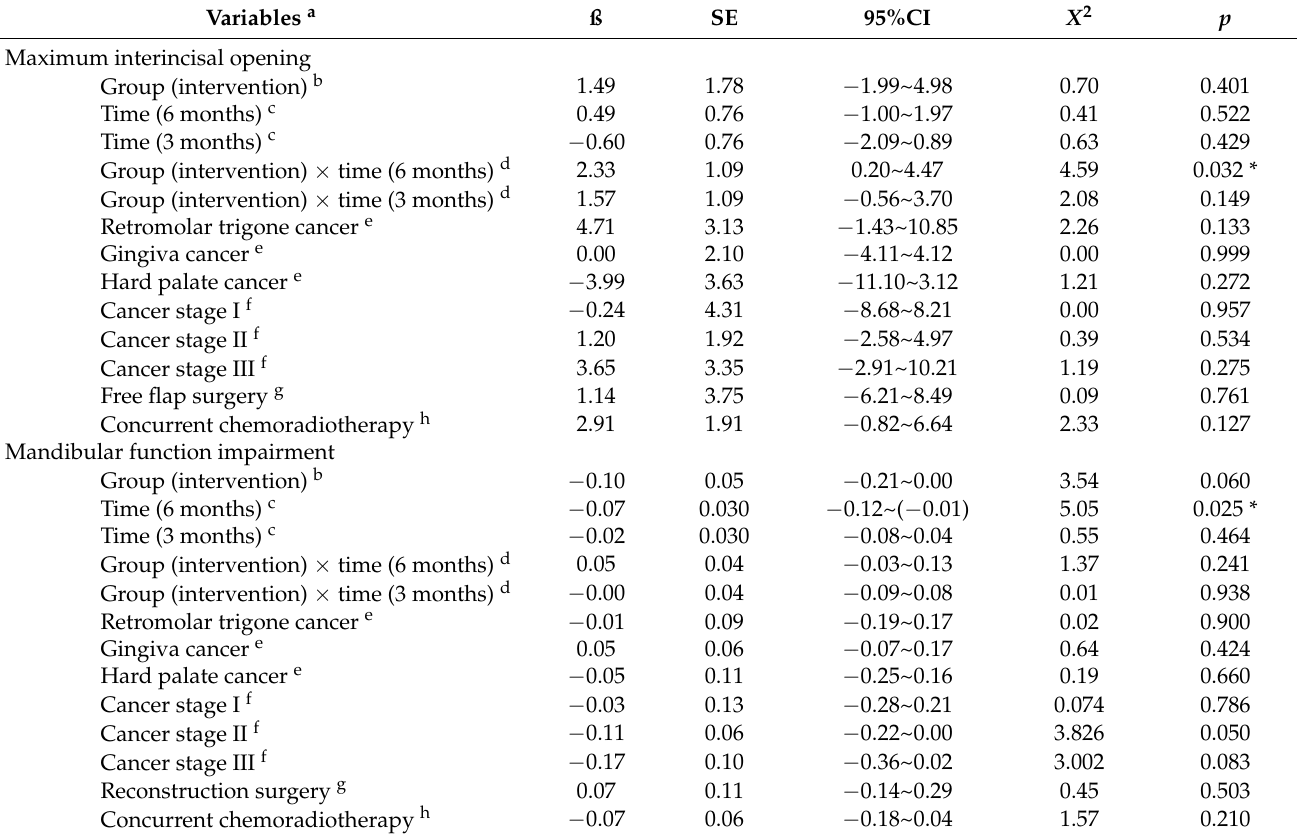
a Using generalized estimating equation for repeated measurements and an exchangeable correlation structure.